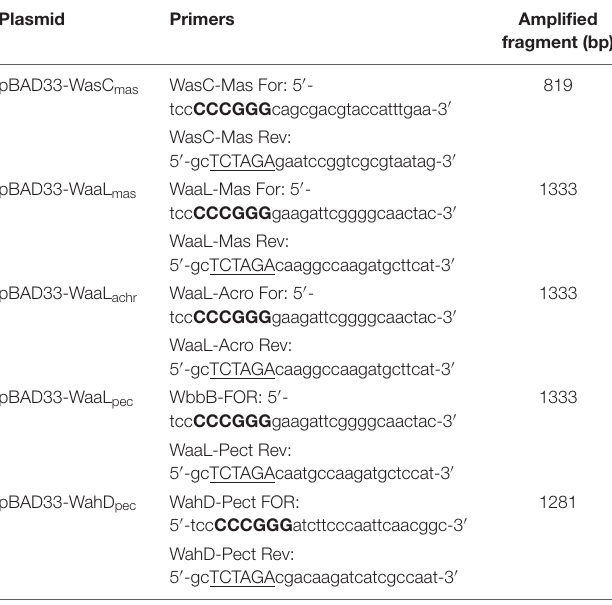
TABLE 2 | Primers used for mutant complementation using vector